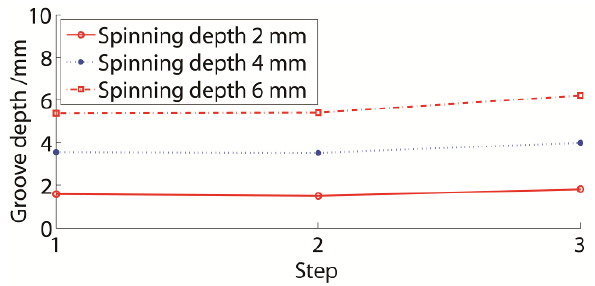
Figure 14. Groove depth variation of three-groove sheave during spinning.